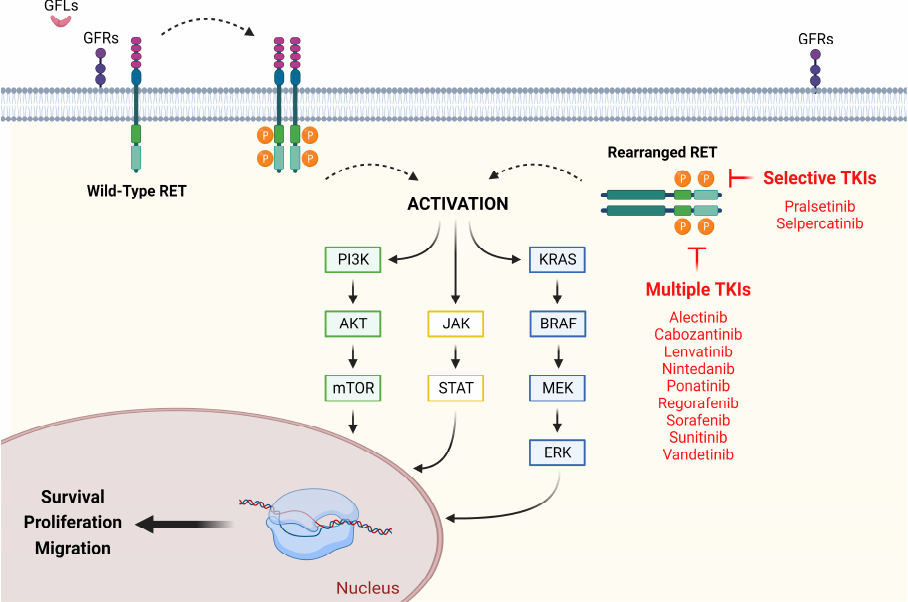
Figure 1. RET signaling in NSCLC: existing therapeutic strategies for its neutralization. Typically, RET activation requires a pre-binding between GFLs and GFRs, as well as between Ca 2+ and cadherin-like domains, which in turn allow homodimerization and autophosphorylation of the cytosolic tyrosine kinase domains. Genetic rearrangements of RET cause loss of transmembrane domain, resulting in a ligand-independent and constitutively activated chimeric cytosolic protein. Once active, RET switch-on different pathways, such as P13K/AKT, RAS/MAPK, and JAK/STAT, promoting survival, proliferation, and migration. Multiple and selective TKIs constrain the above vicious circle by competing with ATP for binding. AKT (protein kinase B); BRAF (v-raf murine sarcoma viral oncogene homolog B1); ERK (extracellular signal-regulated kinase); GFLs (glial-derived neurotrophic factor ligands); GFRs (glial-derived neurotrophic factor family receptors); JAK (Janus Kinase); KRAS (Kirsten rat sarcoma); MEK (mitogen-activated protein kinase kinase), mTOR (mammalian target of rapamycin); PI3K (PhosphatidylInositol 3-Kinase); RET (rearranged during transfection); STAT (signal transducer and activator of transcription). Created with BioRender.com (accessed on 21 December